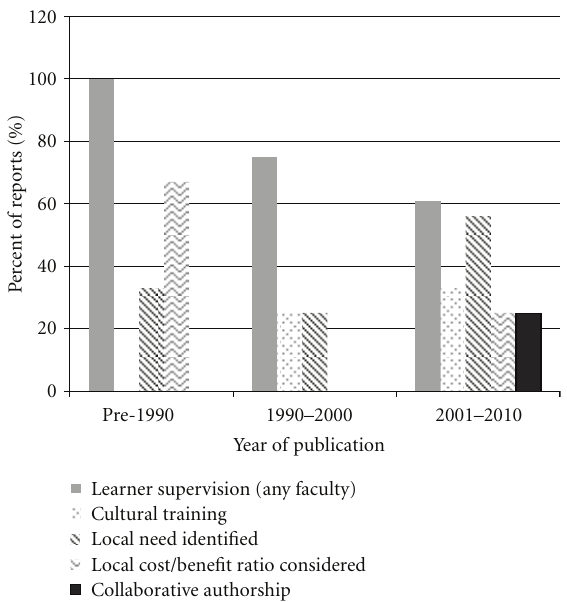
Figure 1: Principles of reciprocity in published reports on global health partnerships from 1970 to 2010.